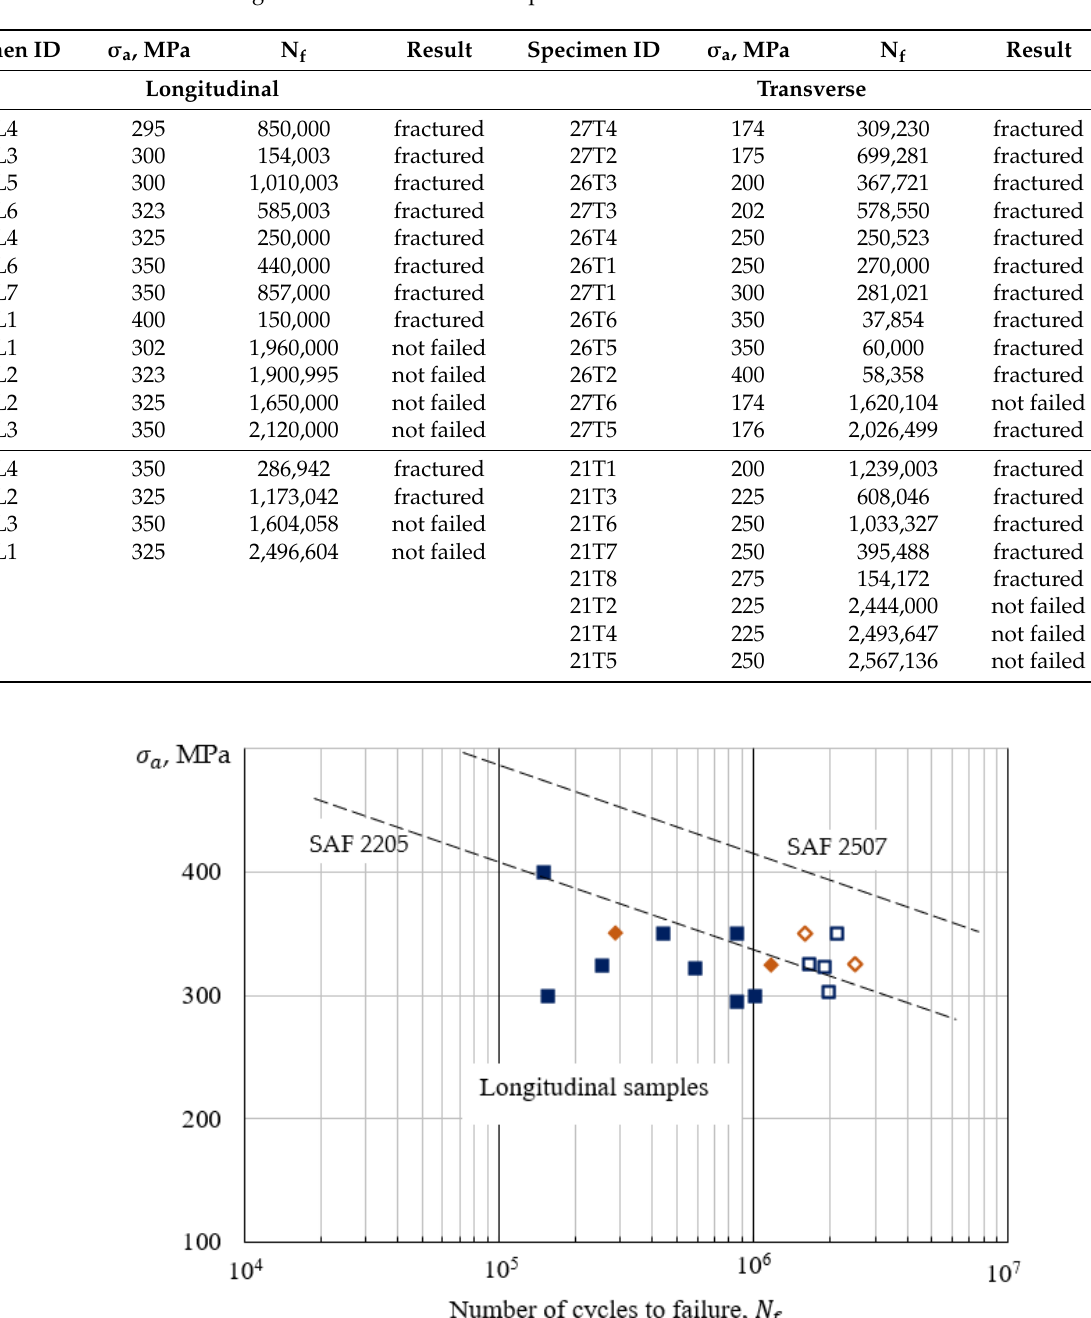
Table 3. Fatigue data results for all test specimens.